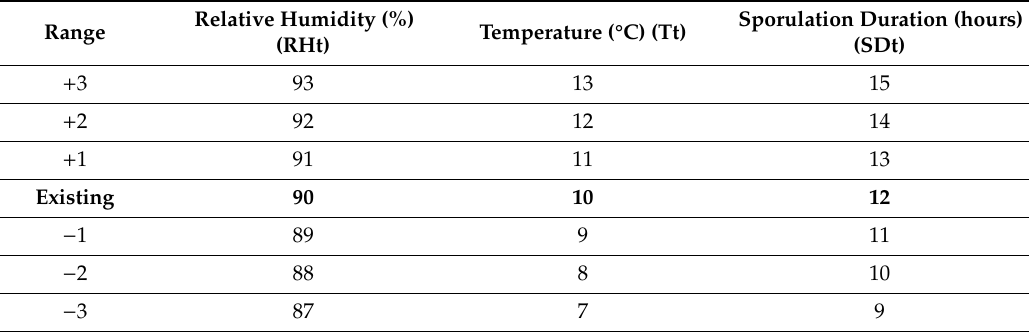
Table 2. Model variable threshold variations evaluated in the